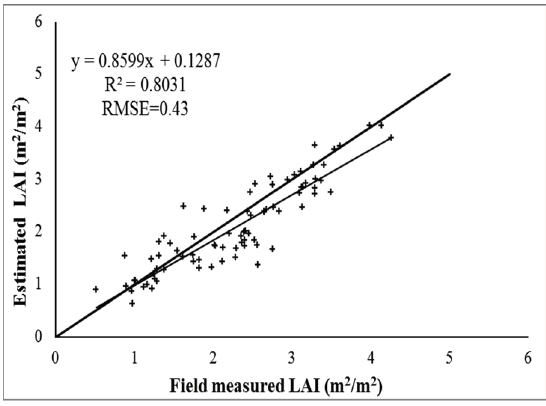
Figure 4. The scatter plot figure with the estimated and field-measured